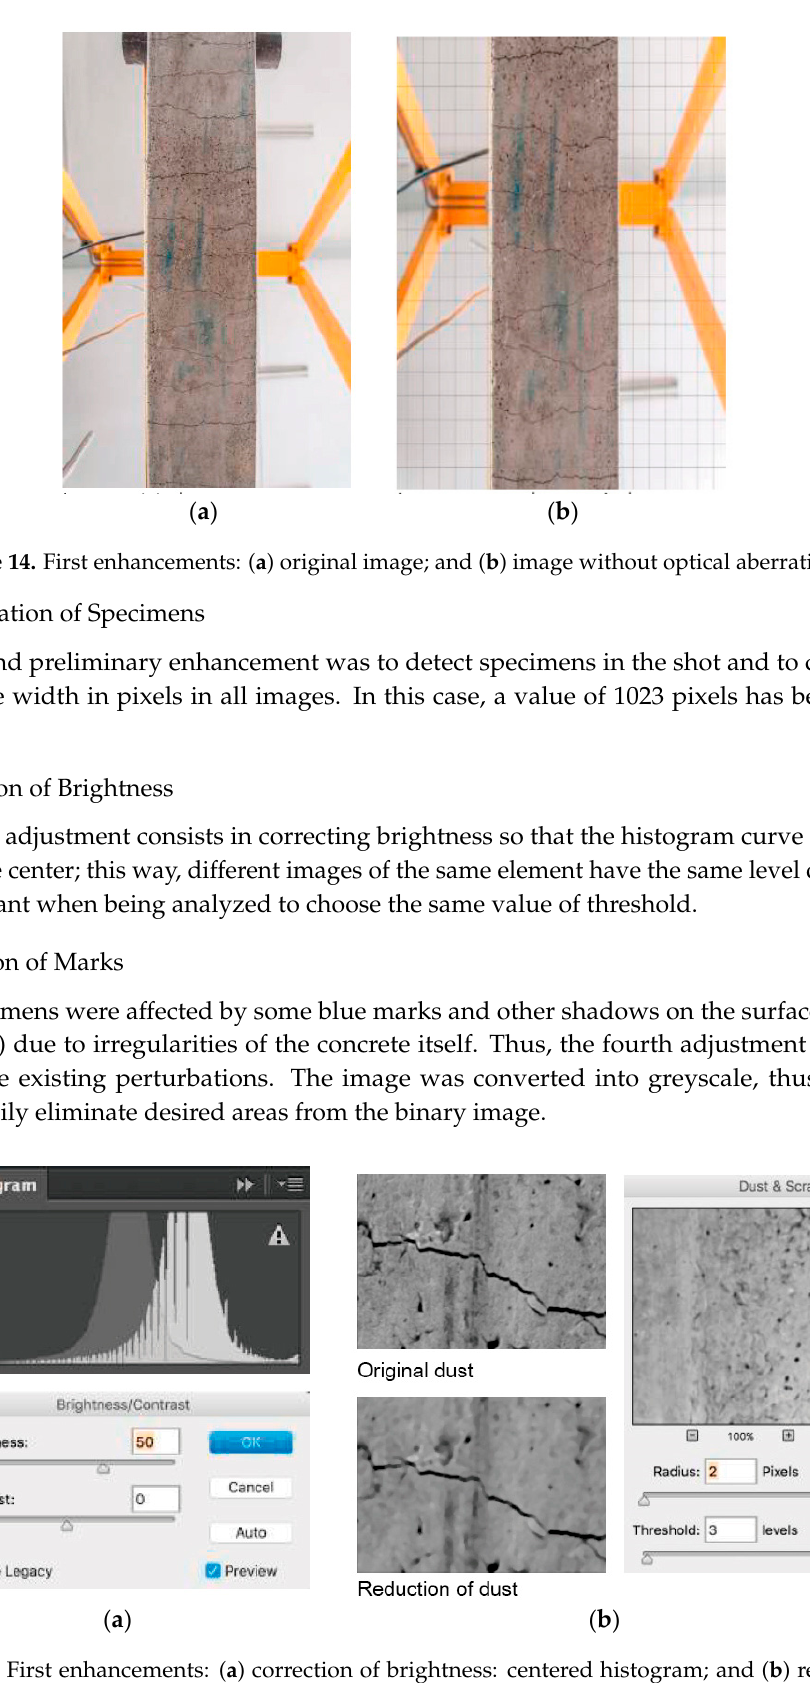
Figure 14. First enhancements: ( a ) original image; and ( b ) image without optical aberrations.